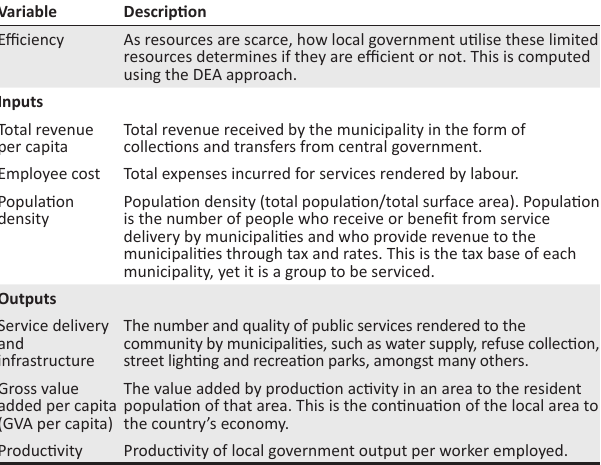
TABLE 1: Description of the variables on